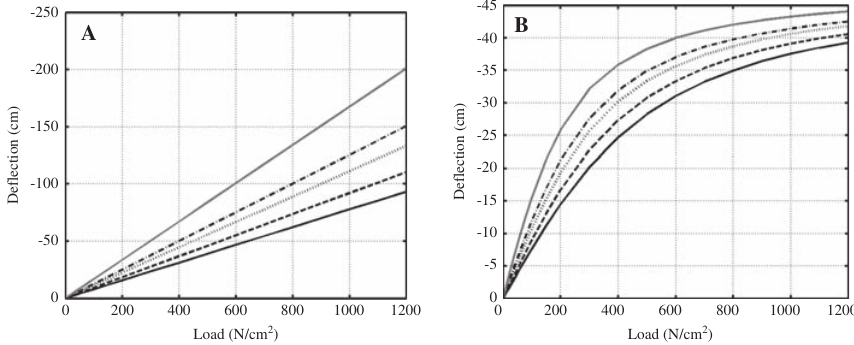
Figure 8 Load-tip transverse displacement curves for various values of the power-law exponent. ( – – – – ) Full ceramic, ( – – – ) k = 0.3, (------) k = 1, ( – – – ) k = 3, ( – – – – ) full metal, (A) linear case, (B) non-linear